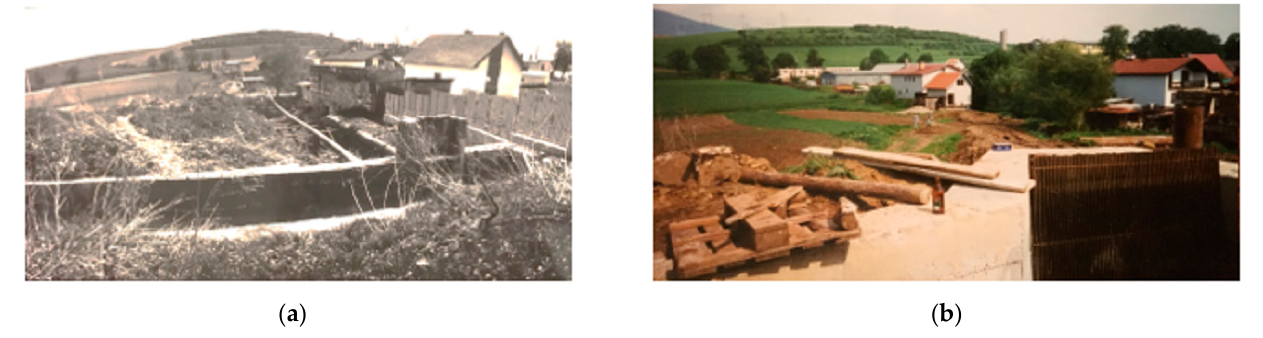
Figure 6. Process of the construction of SHP Žehrica and SHP Žehrica II. Source: Lukas Olejnik, accessed date: May 2019. ( a ) In the foreground the original entrance building, in the middle the remains of the mill, in the background the SHP building; ( b ) New entrance building of SHP Žehrica II., in the background the building of SHP